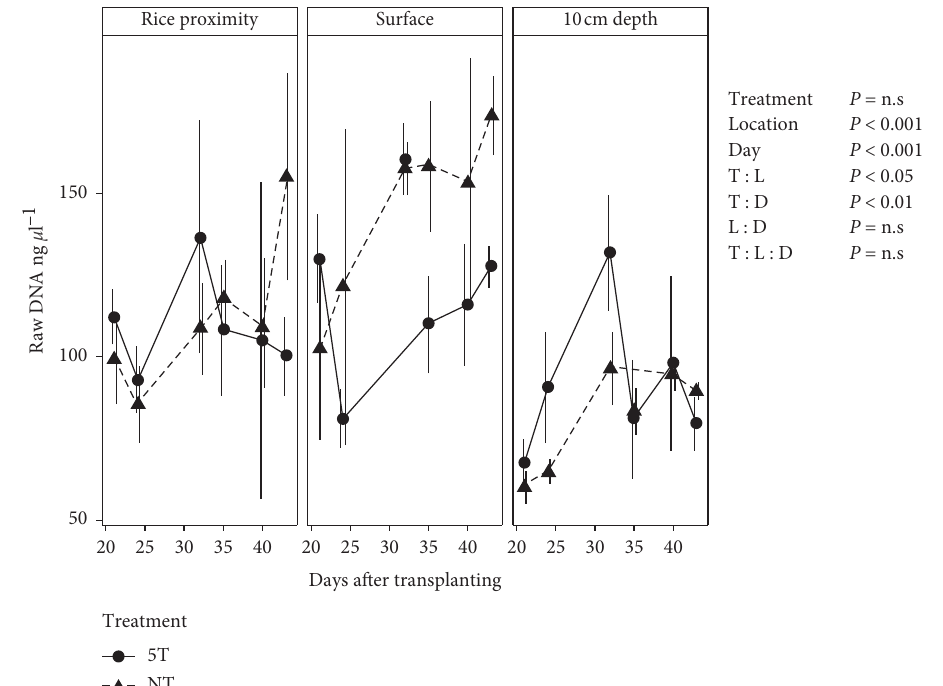
Figure 2: The time course changes of raw DNA under no tillage (NT) and 5 times tillage (5T) at three different locations (rice proximity, surface, and 10cm depth) after transplanting. Level of significance was determined by two-way ANOVA. Error bars indicate standard deviations ( n �